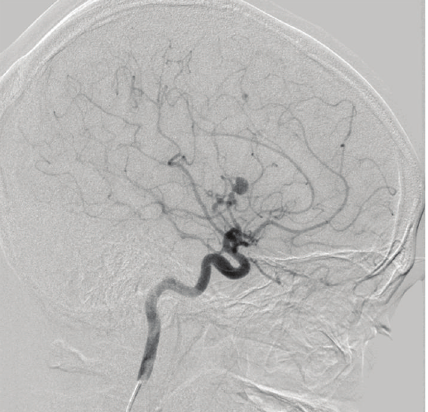
Figure 1: Oblique CTA scans demonstrating an ectatic fusiform dilatation of the involved MCA distal branch with aneurysm, in addition to saccular smaller aneurysm at the origin of MCA bifurcation.